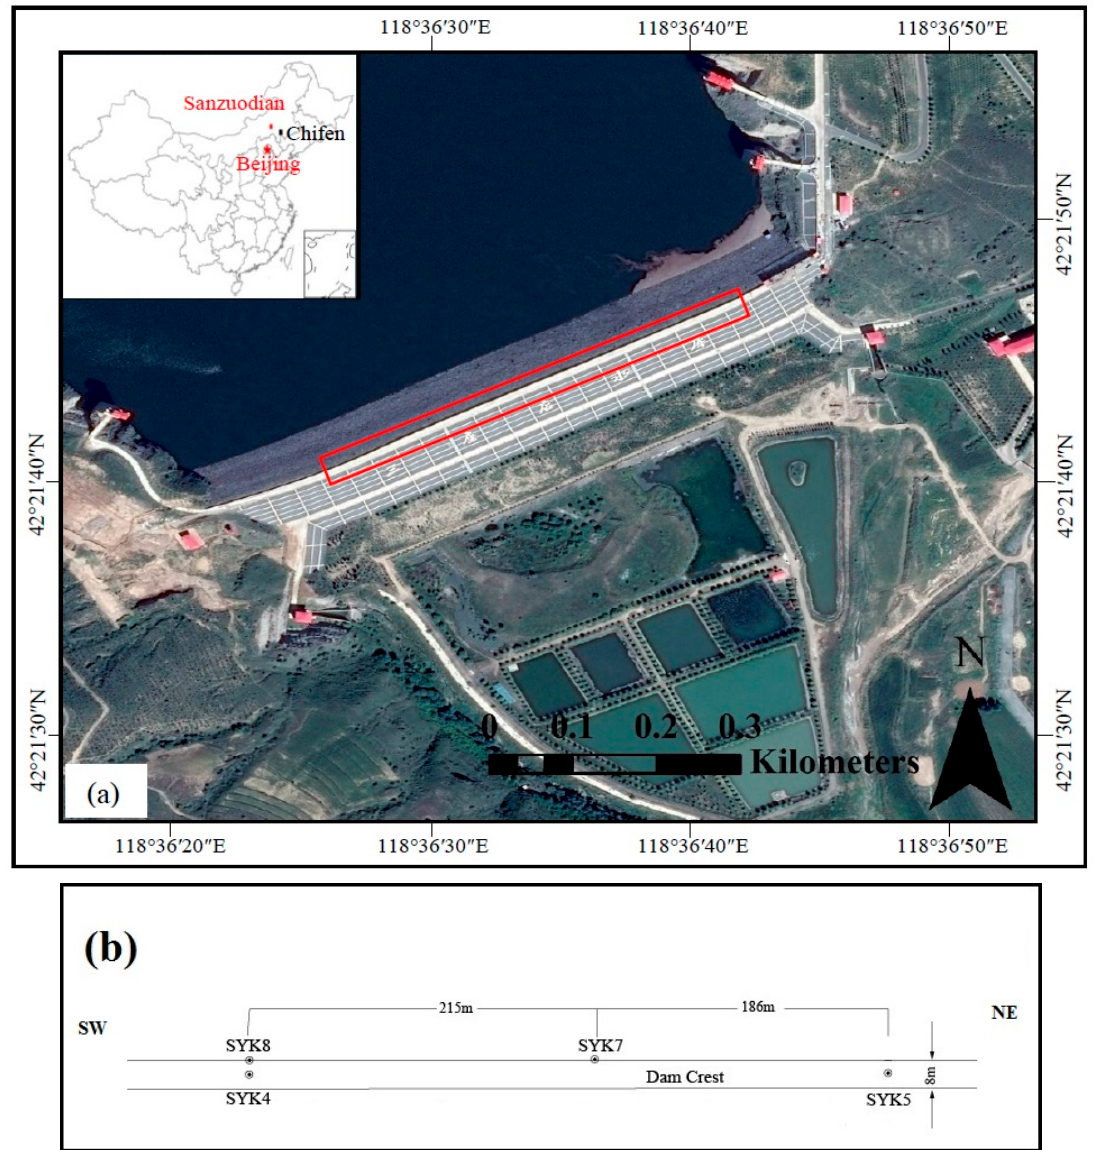
Figure 1. ( a ) Location of the investigated water reservoir and its satellite photo. ( b ) Plain view marking the position of the boreholes along the dam as marked by a red box in ( a